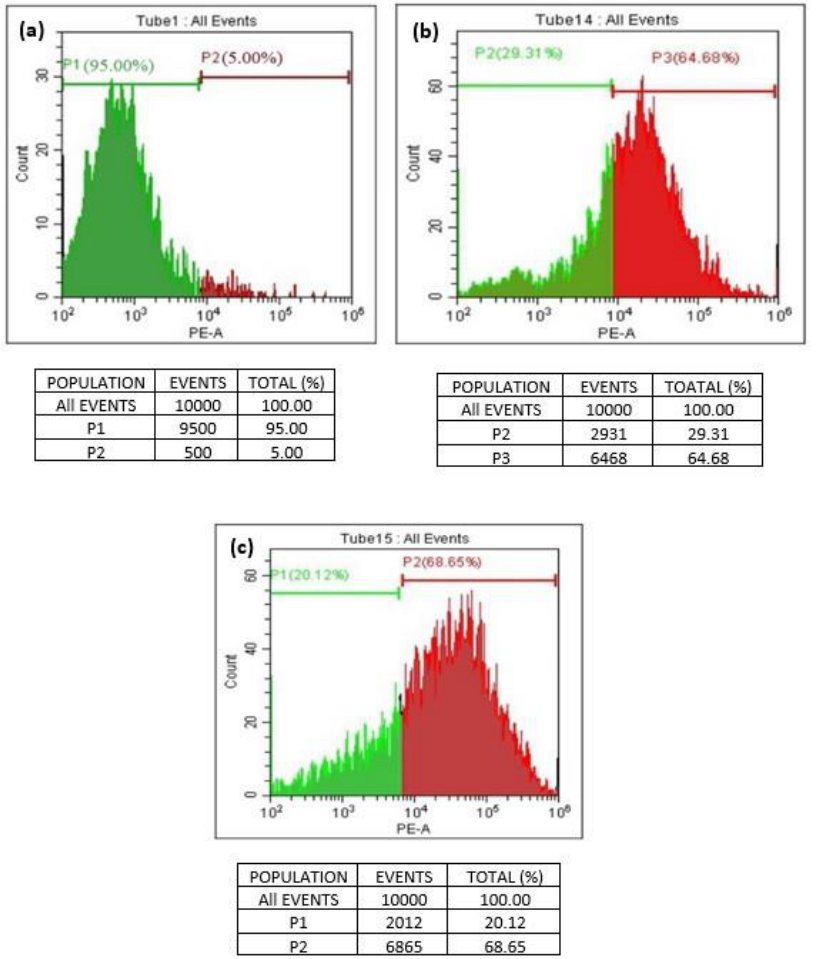
Figure 10. ( a – c ) Flowcytometric detection of apoptosis in phase of human lung cancer cells ( a : con- trol; b : GO-treated cells; c : T-rGO-treated